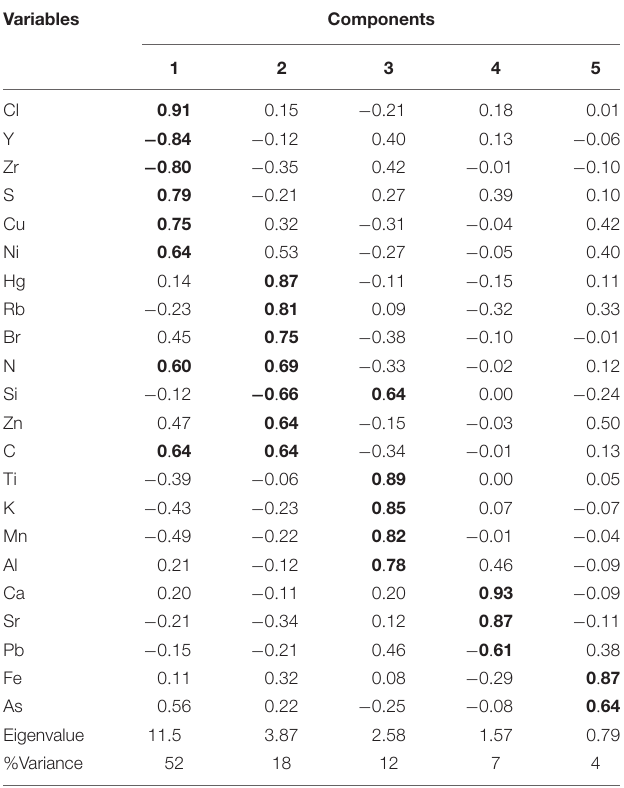
TABLE 2 | Factor loadings for the five significant components extracted by PCA from Peru Margin sediment samples.